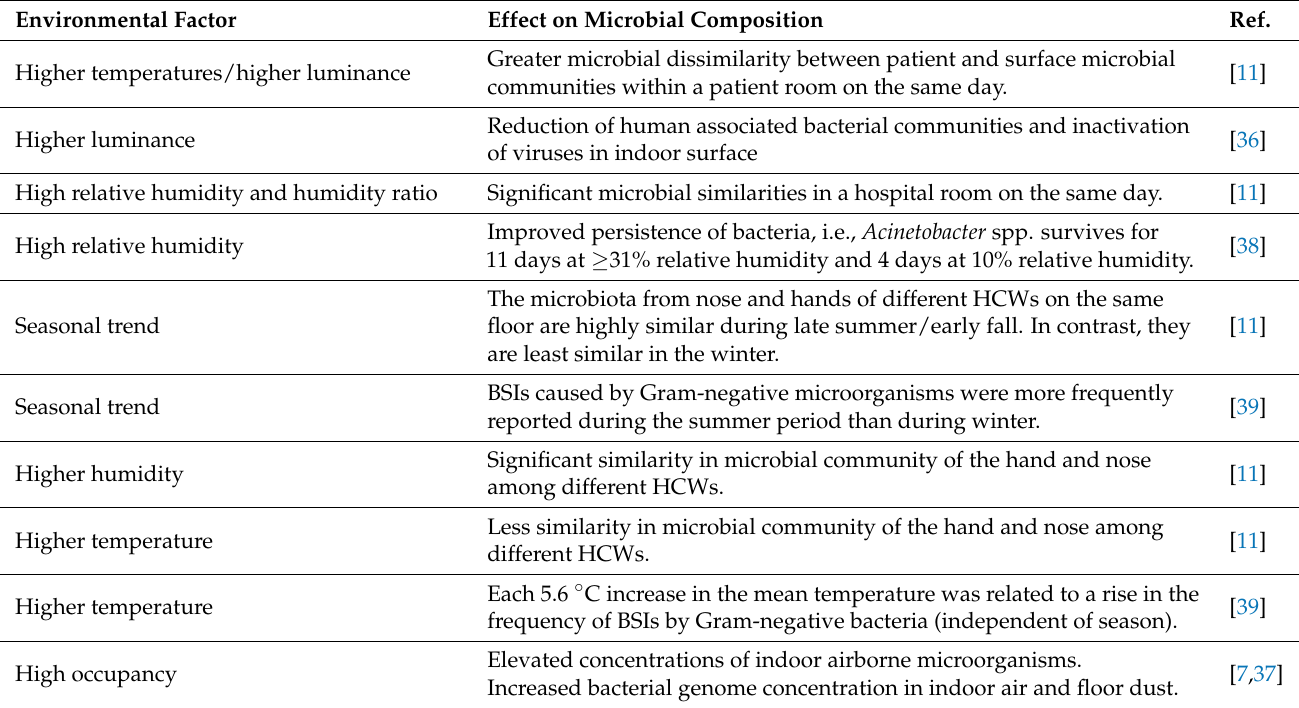
Table 3. Effect of environmental conditions on microbial composition of hospital surfaces. Environmental Factor Effect on Microbial Composition